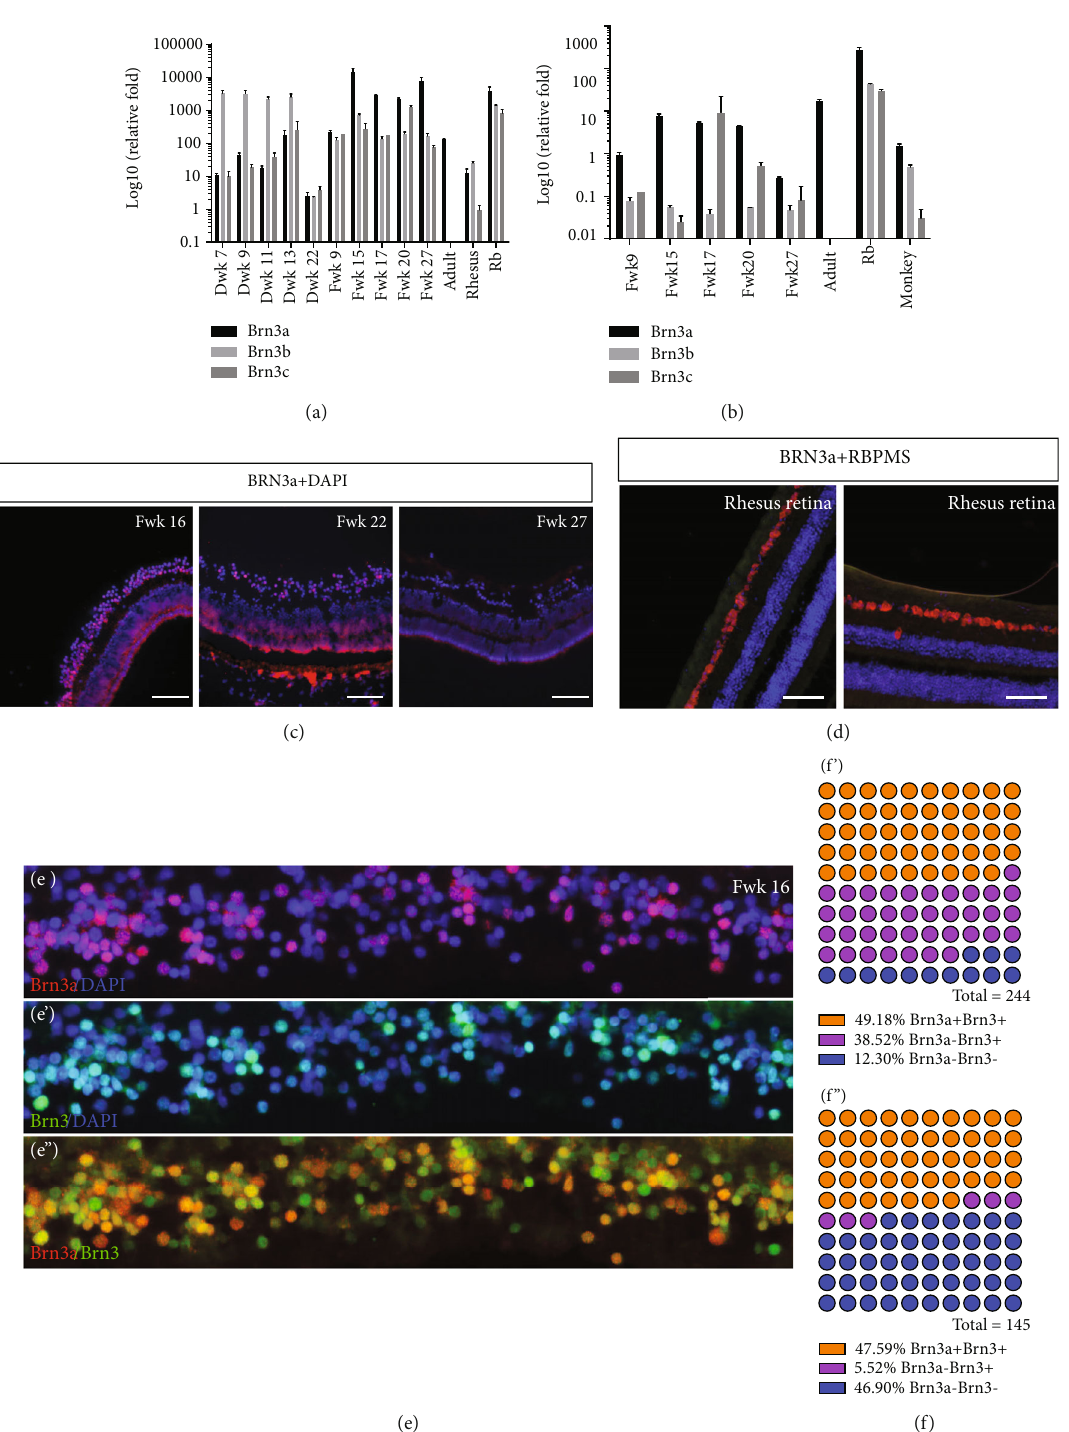
Figure 5: Brn3a expression in human fetal retina, retinal organoid, and rhesus retina. (a) Real-time PCR demonstrated the various expression of Brn3a, b, and c among retinal organoid, fetal retina, adult retina, rhesus retina, and Rb tissue. (b) Considering the rapidly decrease of RGC population in later developmental stage, Brn3a, b, and c expression levels were normalized with RBPMS expression. (c) Brn3a staining in human fetal retina. (d) Costaining of Brn3a and RBPMS in adult rhesus retina. (e – e ″ ) Immunostaining of Brn3a and Brn3 in Fwk 16 fetal retina. (f and f ′ ) Cell counting of central (f) and peripheral (f ′ ) Fwk 16 fetal